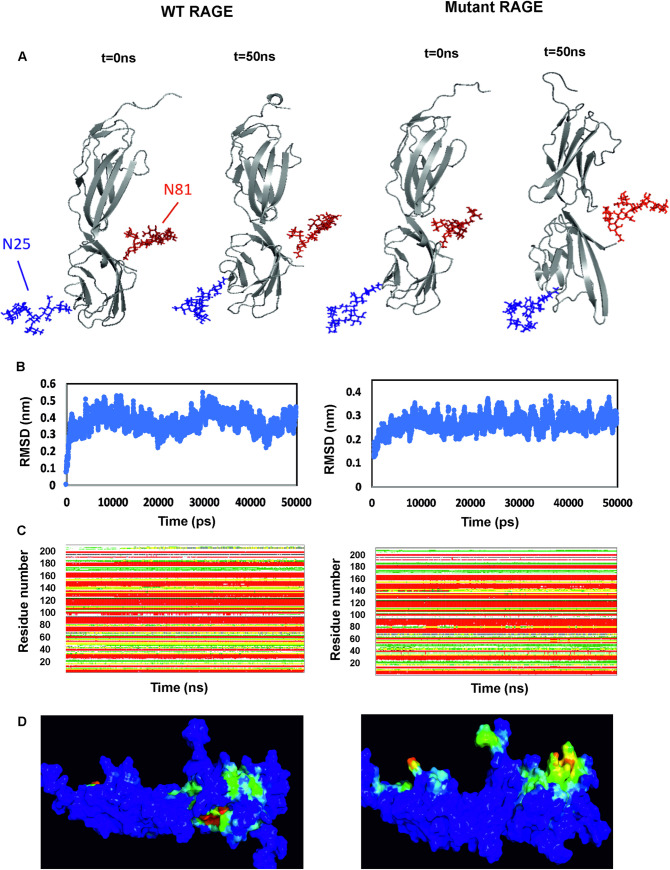
Structure and stability of glycosylated form of WT and mutant RAGE.A) Initial and final conformations of the simulated glycosylated—WT RAGE, Mutant RAGE at t = 0 ns and t = 50 ns. B) Core backbone RMSD. Core backbone residues RMSD over 50 ns from the initial conformations for simulation of WT RAGE and mutant RAGE. C) DSSP analysis of glycosylated WT RAGE and mutant RAGE Coil, Red square β-Sheet, Black square β-Bridge, Orange square Bend, Yellow square Turn, Green square 3-Helix. D) Binding pockets in glycosylated WT RAGE and mutant RAGE. Colors range from blue (low density = no particular cavity) to red (high density = conserved cavity).